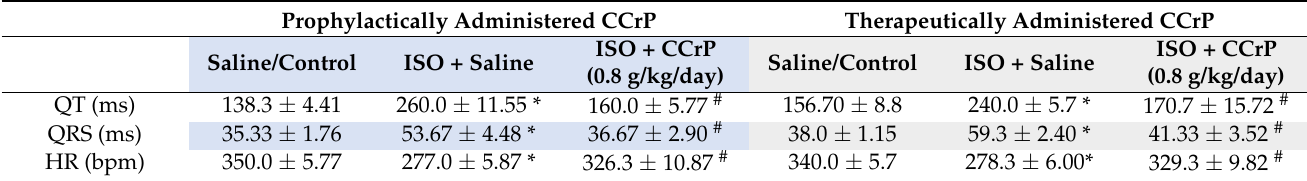
Table 1. ECG changes associated with prophylactic and therapeutic regimens with